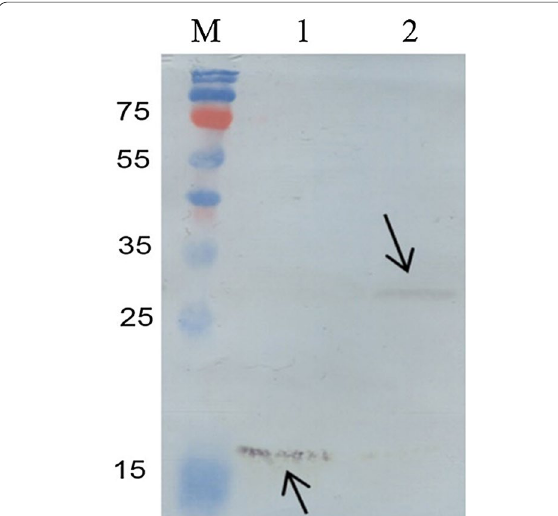
Fig. 6 Lane 1, immunoblotting of the supernatant after treatment of the whole surface displayed recombinant bacterial cell with sortase. Lane 2, immunoblotting of the pellet of the recombinant bacteria after treatment with sortase, almost one band corresponding to the complete chimeric protein is observable. This shows that a few amount of the chimeric protein remains on the surface of the bacteria after treatment with sortase